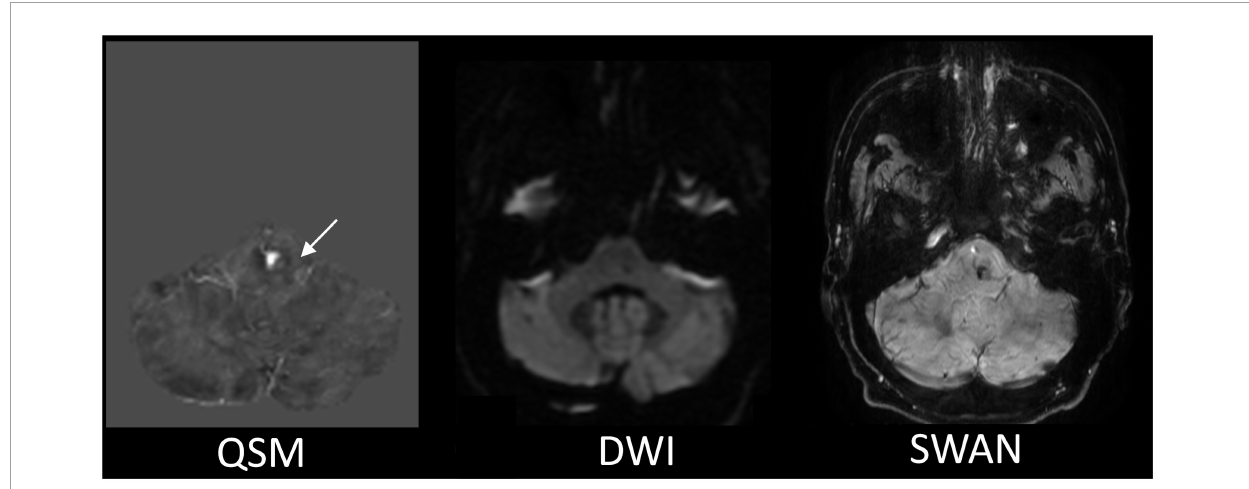
FIGURE2 The representative MR images comparison for the CCM detection. The QSM displays the most apparent boundary of the CCM from among all the MR images we acquired. The white arrow is pointing to the location of the CCM.